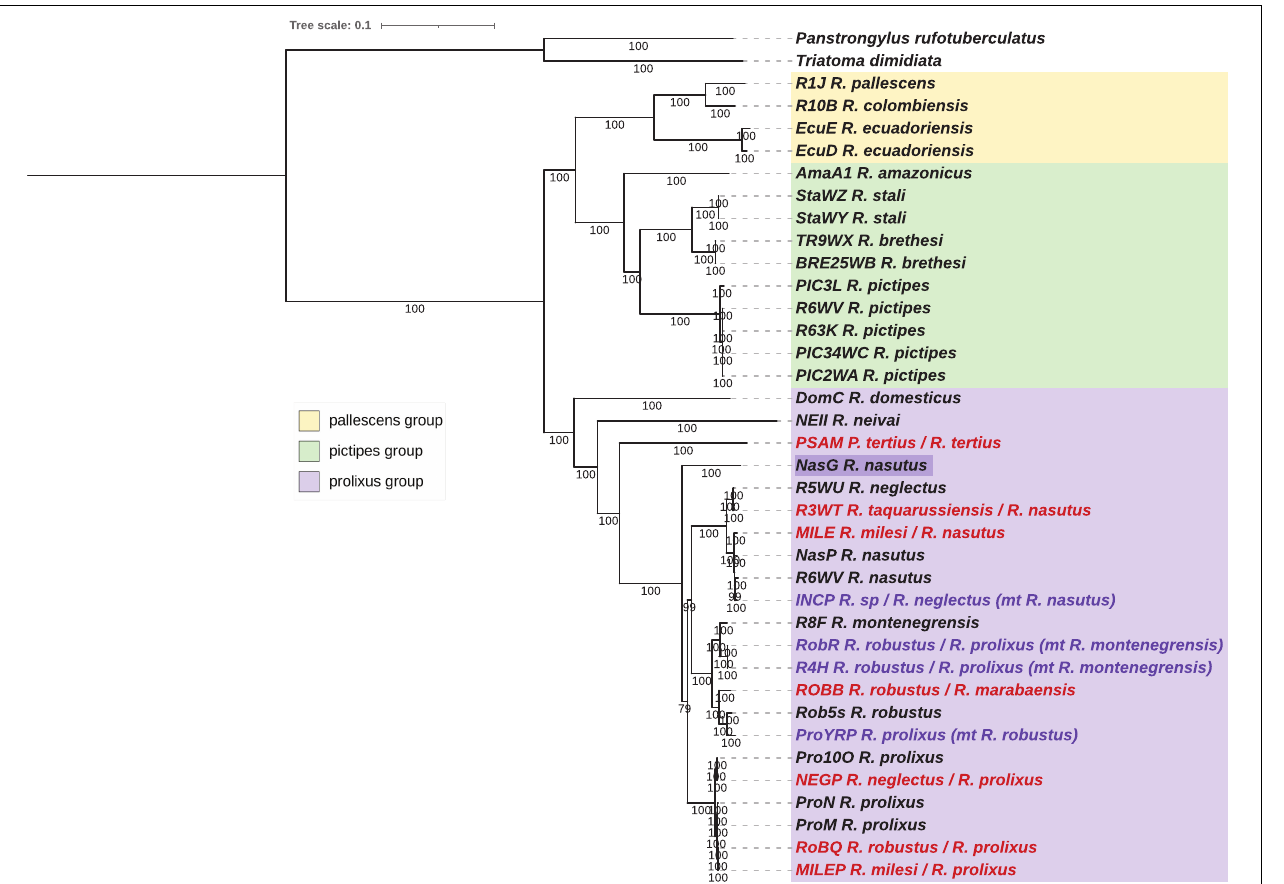
FIGURE 2 | Phylogenetic inferences for the concatenated mitochondrial (mtG) dataset for Rhodnius species using Bayesian Inference (BI) method. Statistical supports (specify Bayesian posterior probabilities in percent) are indicated on the branches. T. dimidiata and P. rufotuberculatus are used as outgroups. Introgressed species inferred from the nuclear phylogeny (see Figure 6 ) are indicated in purple, misidentified species in red, and species with incongruent position are highlighted in dark purple.